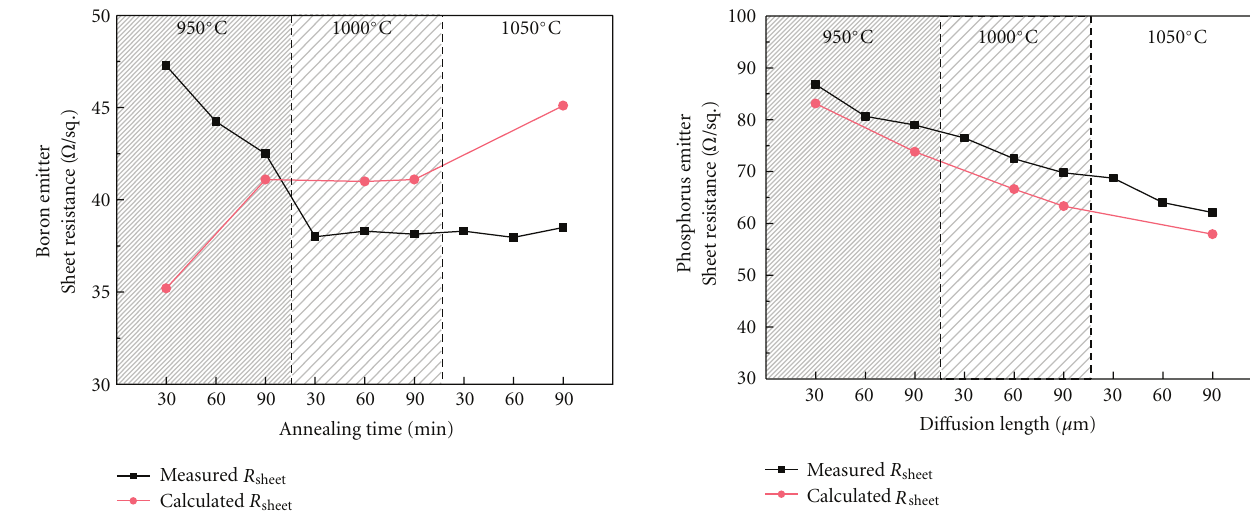
Figure 2: Measured and calculated sheet resistance of boron- implanted samples with di ff erent annealing conditions.